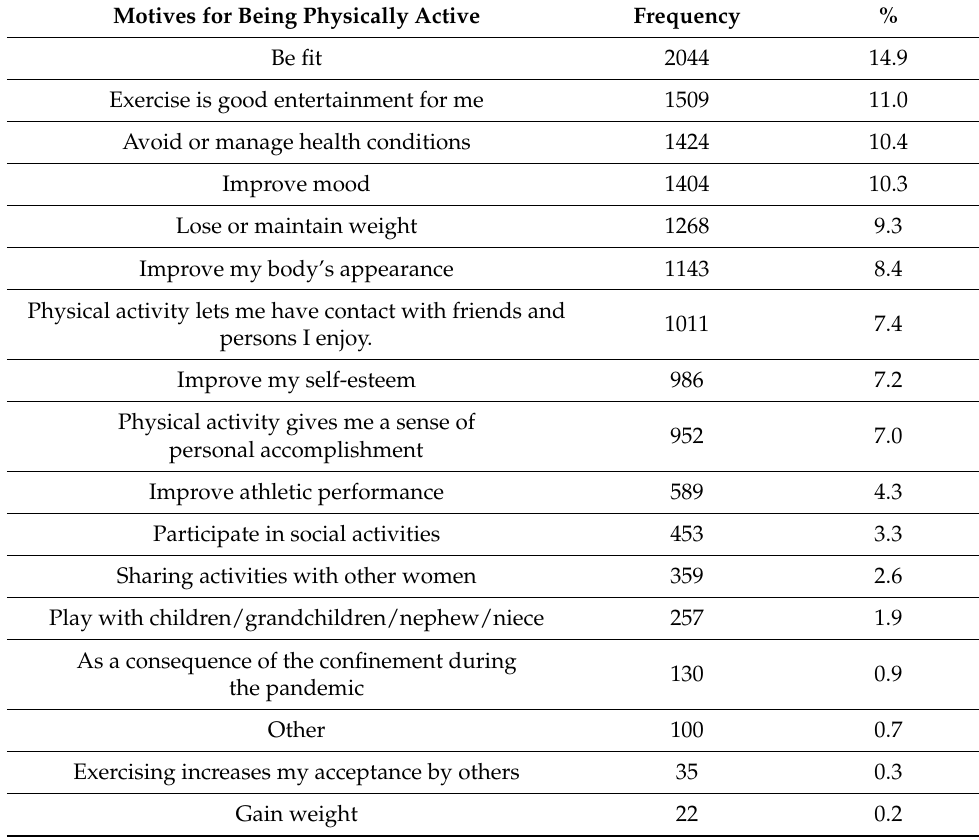
Table 2. Active group participant responses regarding the motives for being physically active in LTPA ( n = 2458 women, total responses = 13,686).